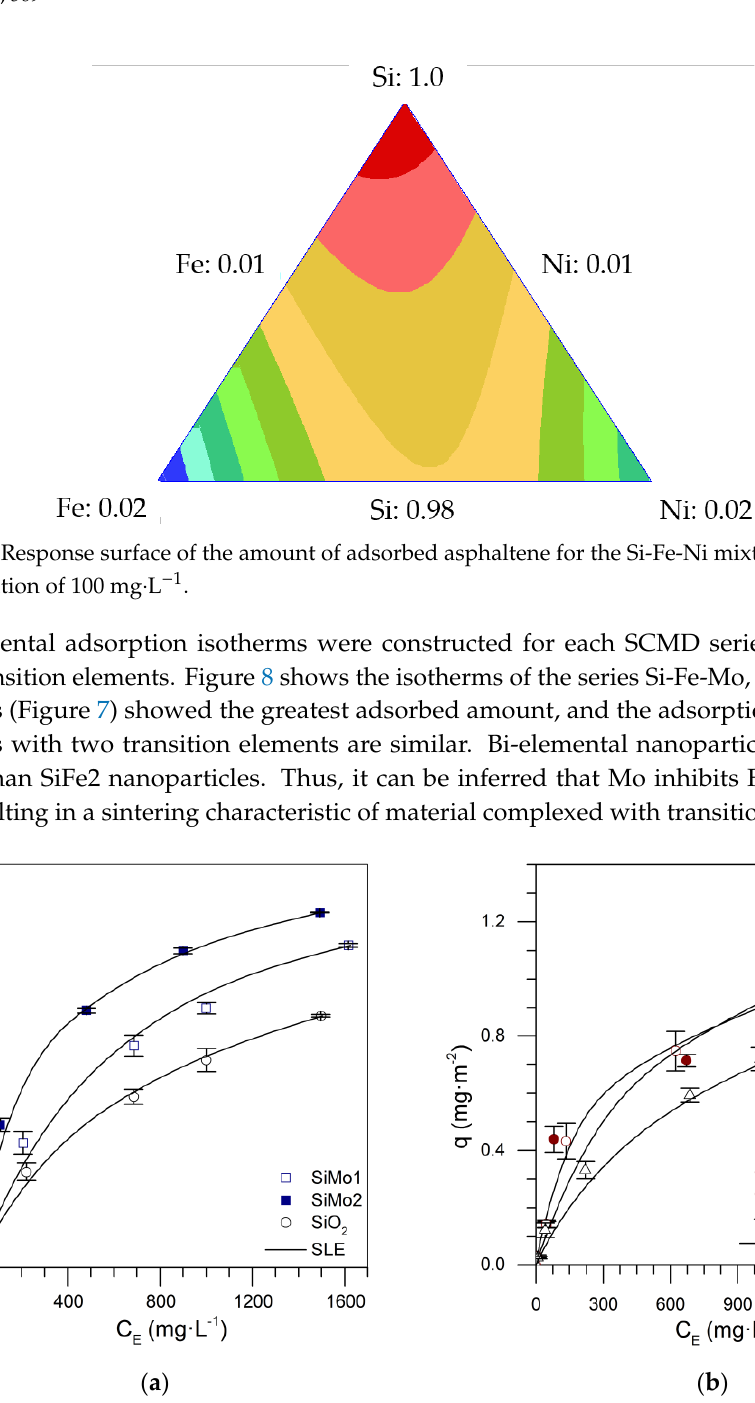
9 of 28 Table 4. Coefficients of the Special Cubic Model for Si-Fe-Ni mixture design. Asphaltene Initial Concentration (mg·L −1 ) ( b ) Figure 6. ( a ) Asphaltene sorption isotherm at 25 °C for SiFe0.5Ni0.5, experimental and theoretical data, and ( b ) trace plot at 100 mg·L-1 for Si-Fe-Ni mixture design . Figure 6b shows the trace plot for the S-Fe-Ni series, in which it is observed that, when the